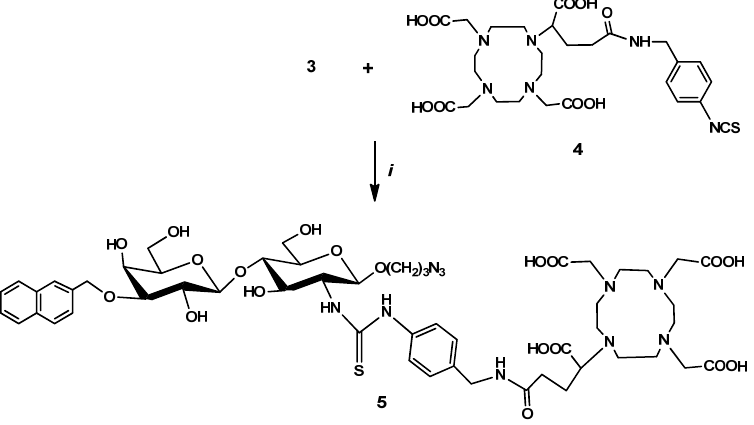
Figure 2 . Reagents and conditions (i) DMSO, Na 2 CO 3 buffer (0.1 M, pH 9.5), rt, 24 h, 28%. Chelator-conjugated lactosamine derivative 5 —labeled with 68 Ga isotope—on the one hand was used for biological studies, whereas on the other hand, compound 5 provided one of the building blocks of the desired heterodimer radiopharmaceutical. Another building block of the heterodimer was a cRGDfK peptide functionalized with a pegylated DBCO unit for the click reaction. Accordingly, the cRGDfK ( 7 ) peptide was coupled with PEG4-DBCO-NHS ( 6 ) in a mixture of DMSO and DIPEA to yield compound 8 (Figure 3).